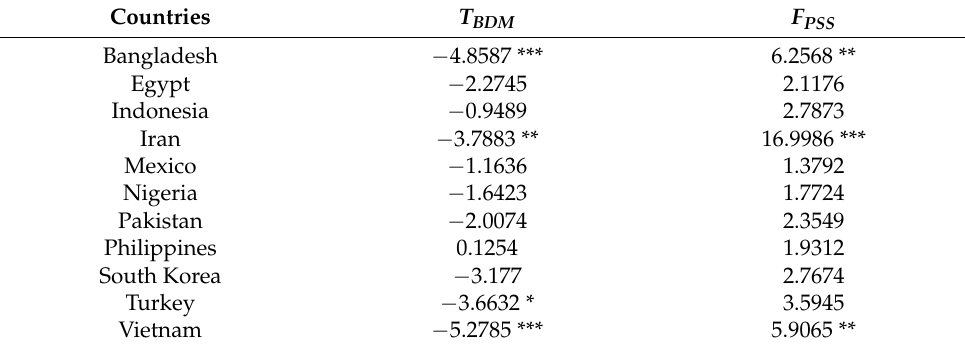
Table 8. Nonlinear cointegration results.